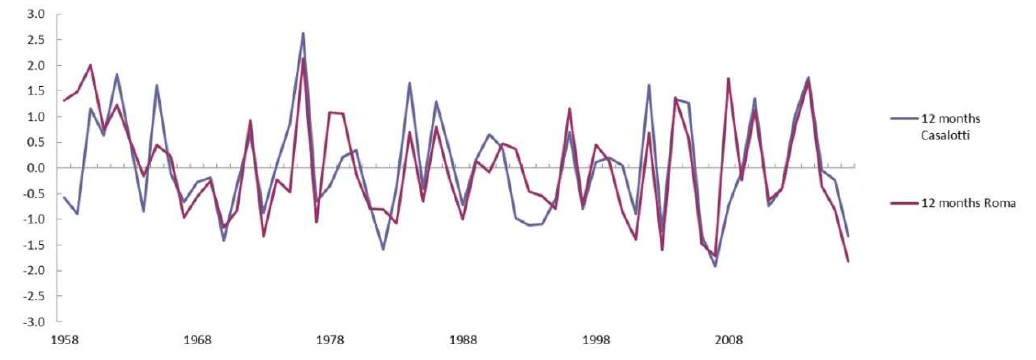
Figure 6. Standardized Precipitation Index (6 months’ time window) in Casalotti (blue) and Collegio Romano (red) by year, 1958–2017 from top to low panels: autumn-winter ( a ) and spring-summer ( b ).